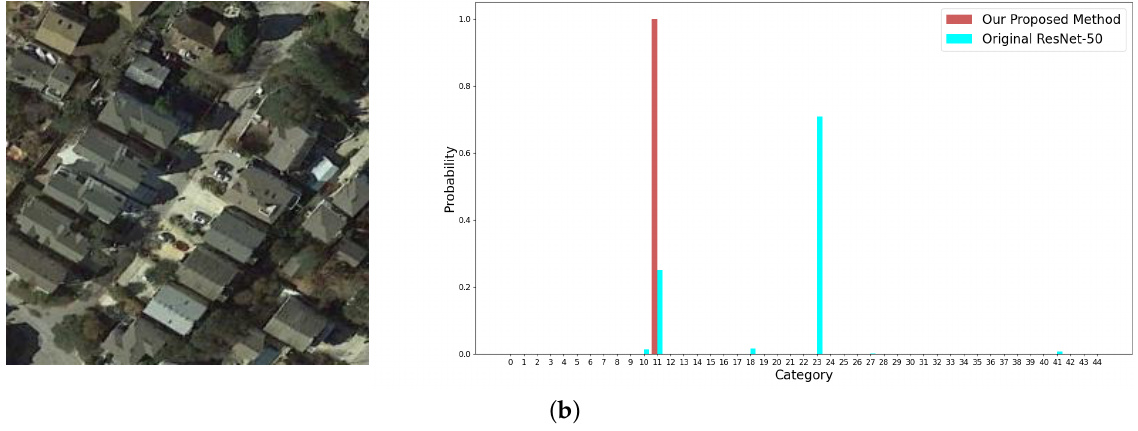
Figure 14. Examples from the NWPU-RESISC 45 dataset and the corresponding output probabilities of categories by the original ResNet-50 (plotted in blue columns) and by our proposed method (plotted in red columns). The images in ( a , b ) are labelled as medium residential and dense residential, respectively.